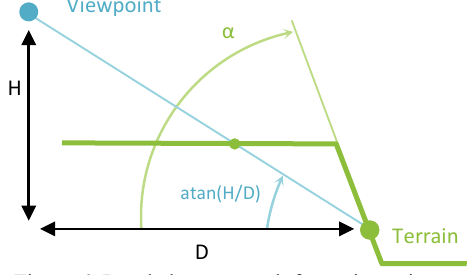
Figure 6. Local slope as mask from viewpoint